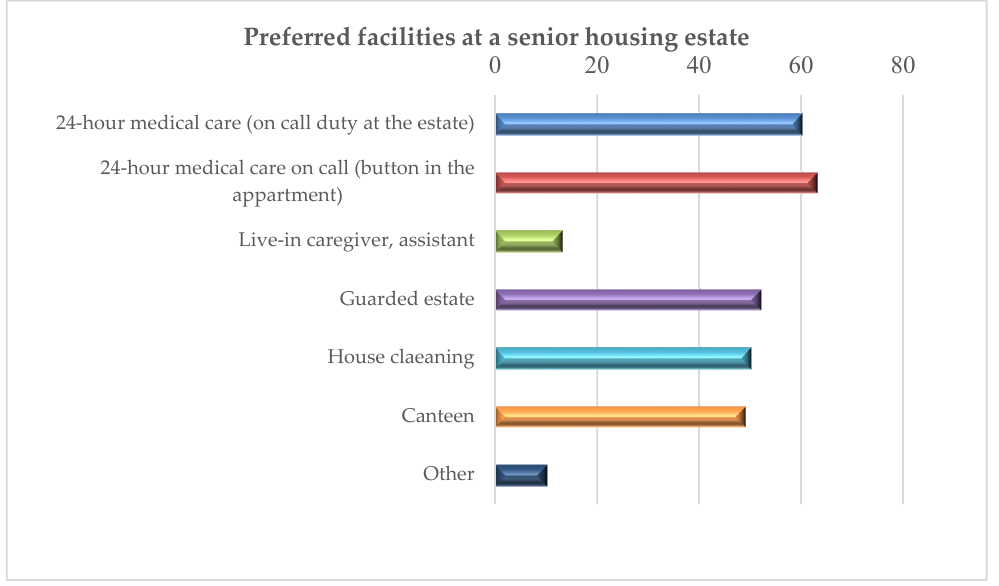
Figure 9. Facilities at a senior housing estate preferred by the respondents (%).